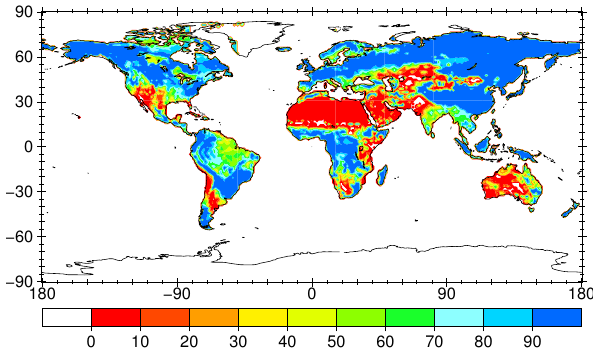
Fig. 7. Percentage of wet soil conditions during the whole simula- tion